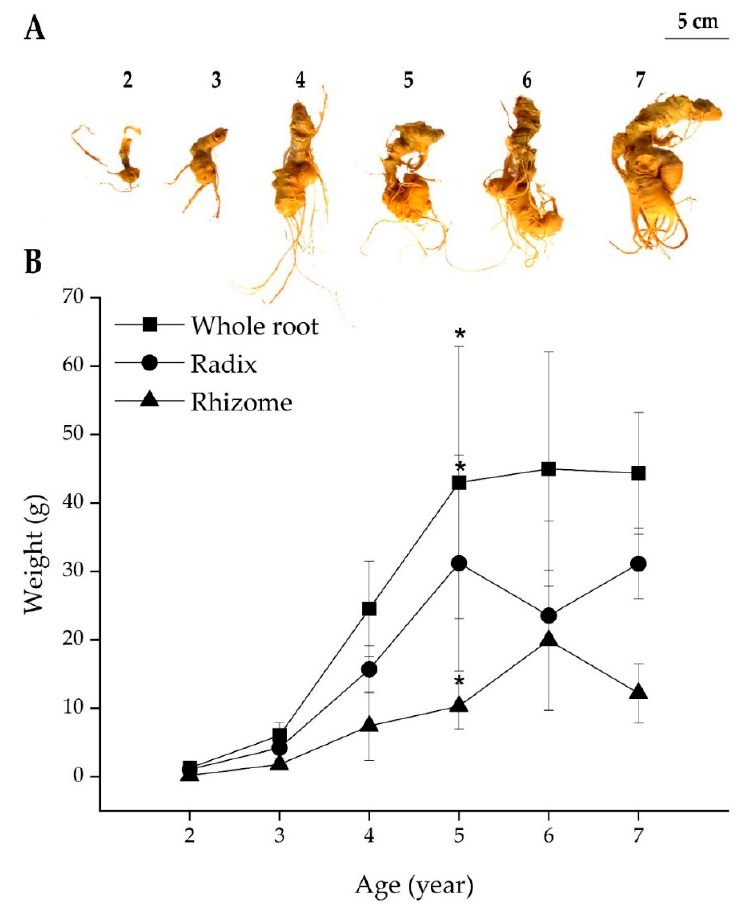
Figure 4. Panax vietnamensis underground parts from age 2–7 years ( A ) and the change of whole root, radix, and rhizome fresh weight of PV from 2–7 years ( B ). Results are expressed as mean ± SD ( n = 5), * p < 0.05 compared with that at age 2 years.